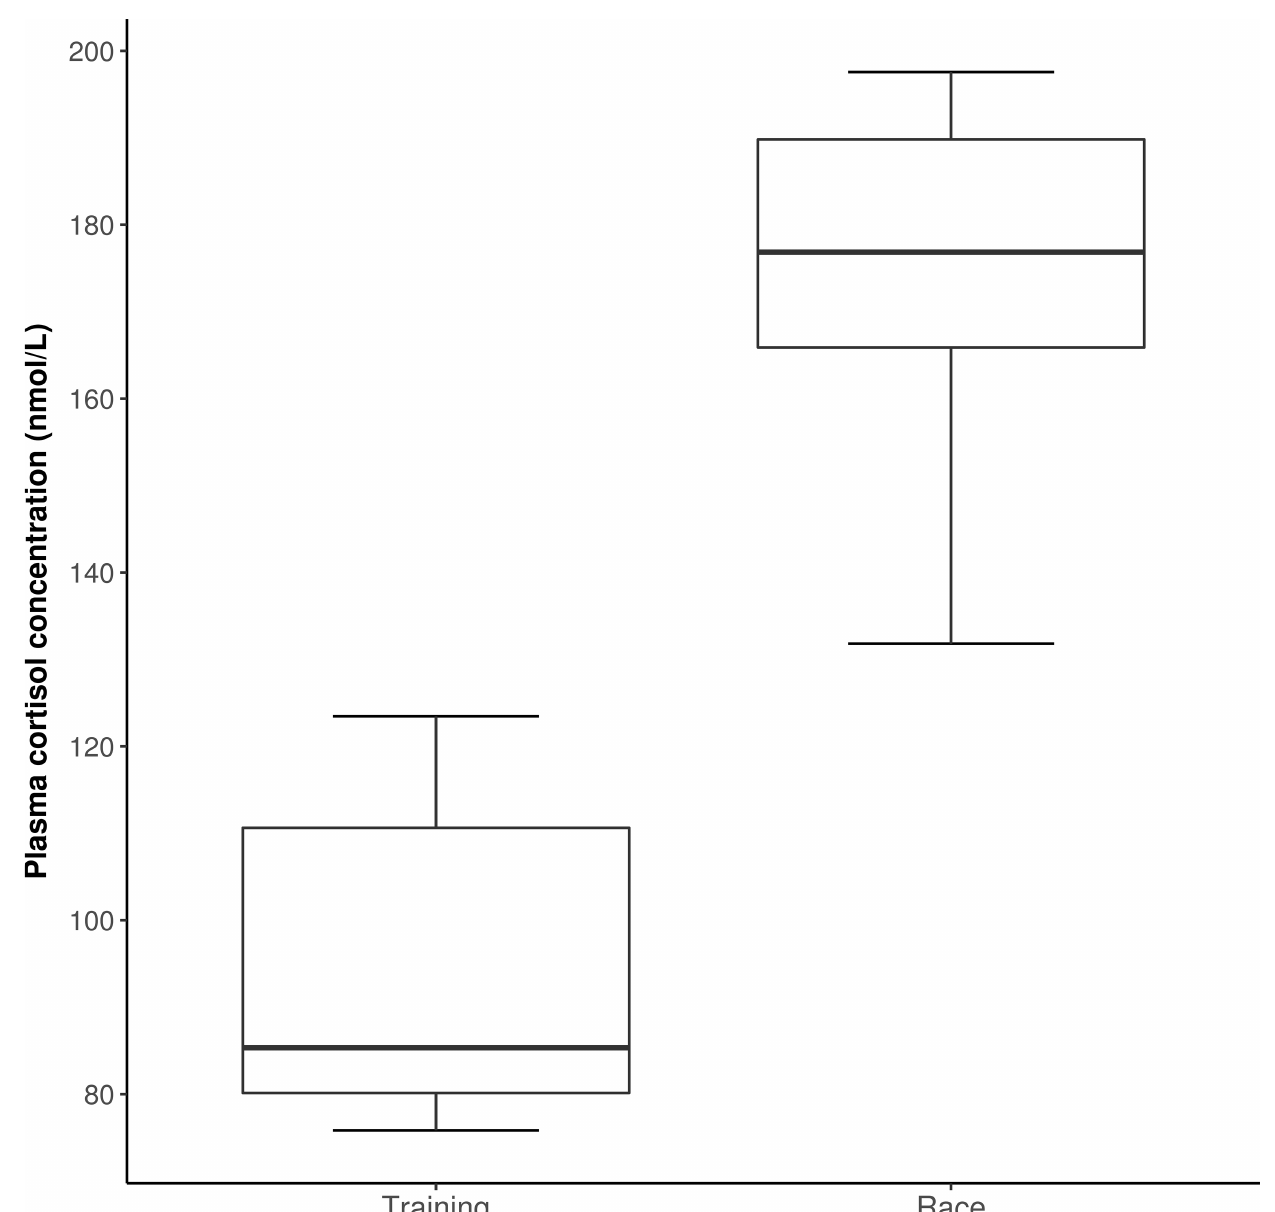
Fig 1. Plasma cortisol levels (median, 25 and 75 percentiles, min/max) of Standardbred racehorses (n = 8) before training and trotting race. Samples were taken between 10:00 and 10:30 AM, 5 min before warming up.